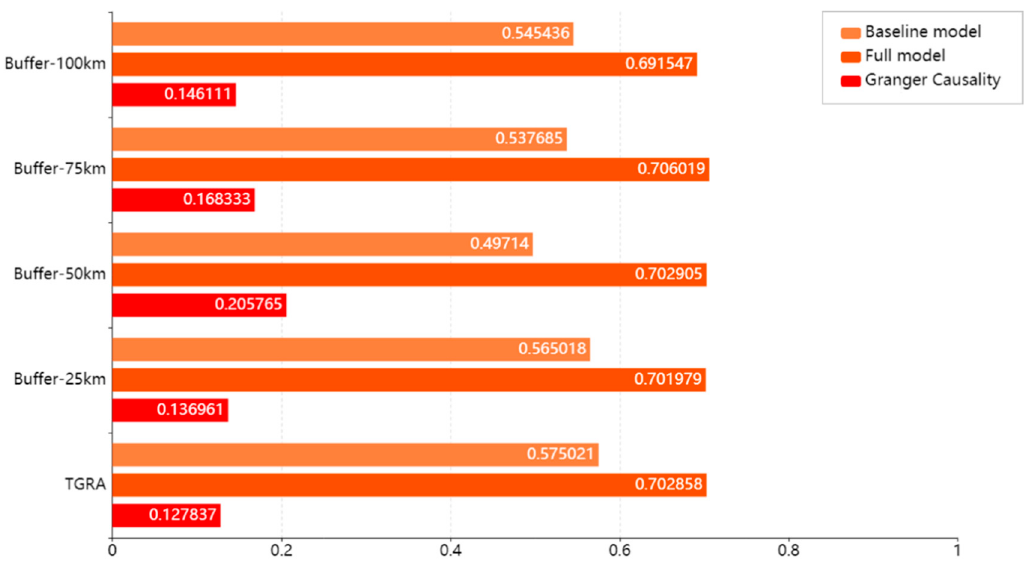
Figure 3. Feedbacks of vegetation dynamics with respect to the cumulative sum of 10 days’ water level.